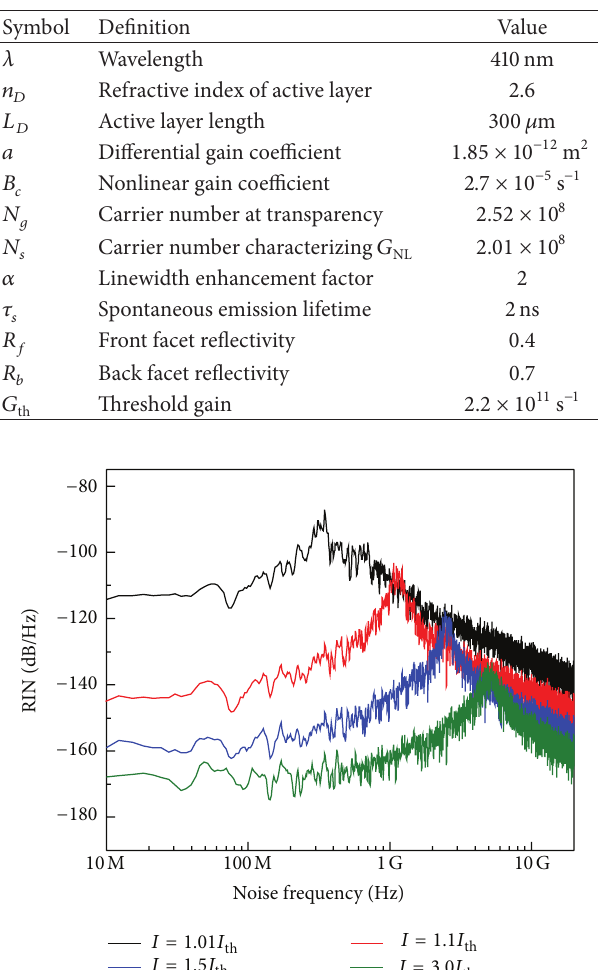
for InGaN lasers. th